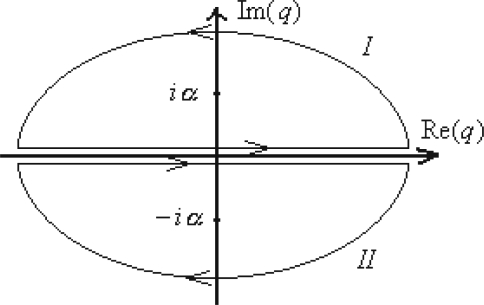
The integration outlines around the poles q = ±iα.